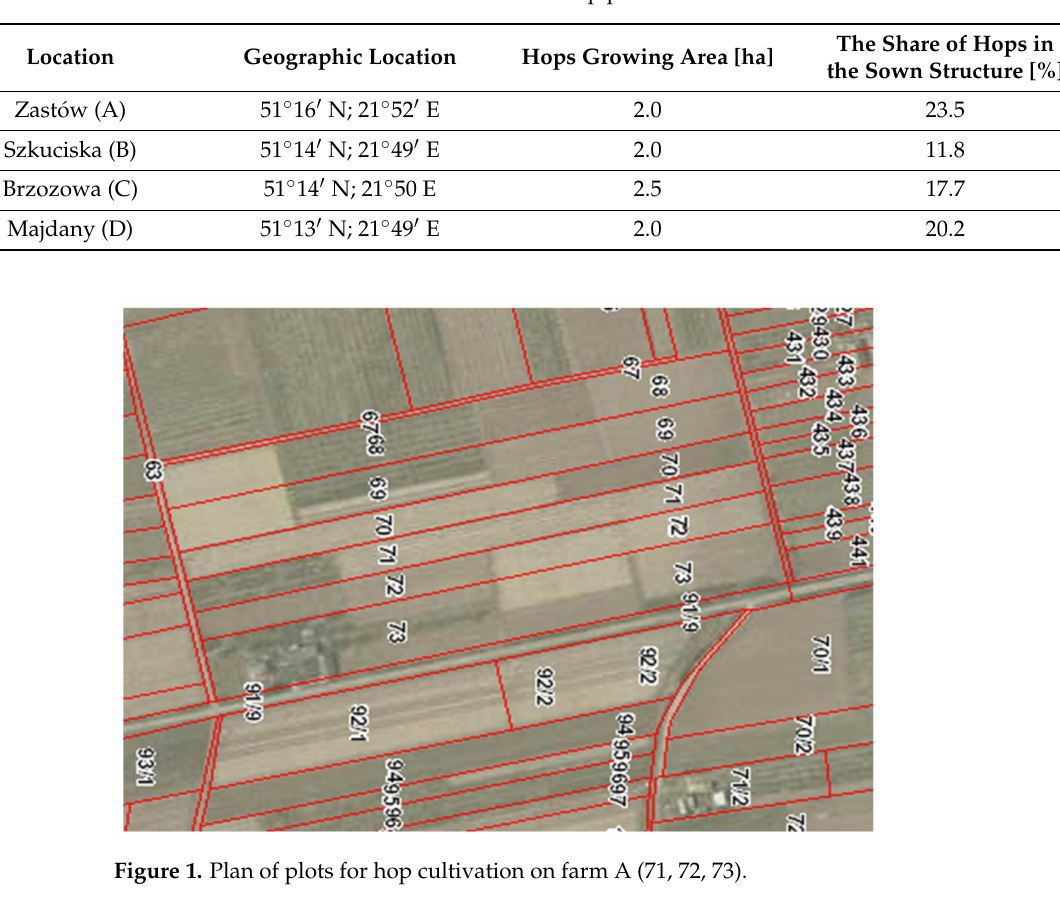
Table 1. Location and size of the studied hop plantations.